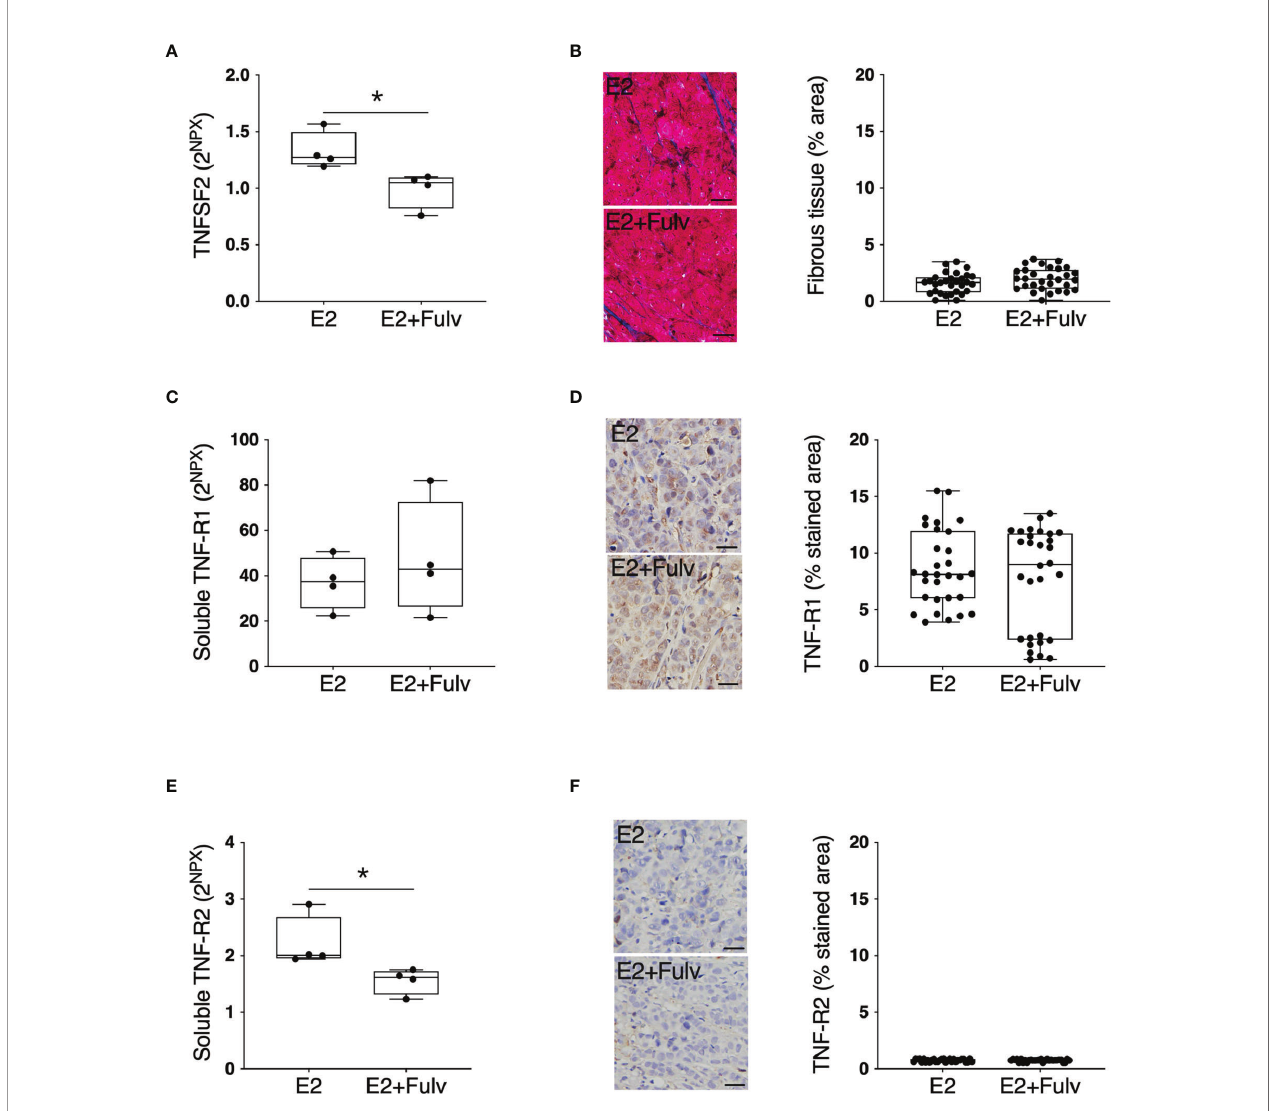
FIGURE 7 | TNFSF2, TNF-R1, and TNF-R2 in experimental ER+ breast cancer. Oophorectomized athymic mice supplemented with physiological levels of estradiol (E2) were injected with MCF-7 into the dorsal mammary fat pads. At similar tumor sizes, mice either continued with E2 or were additionally treated with fulvestrant (E2+Fulv) (5 mg/mouse every 3 days, s.c.). Size-matched tumors from the different treatment groups underwent microdialysis for sampling of extracellular proteins in vivo , which were quanti fi ed using proximity extension assay. Data represents extracellular local protein abundance in linear values (2 NPX as described in the